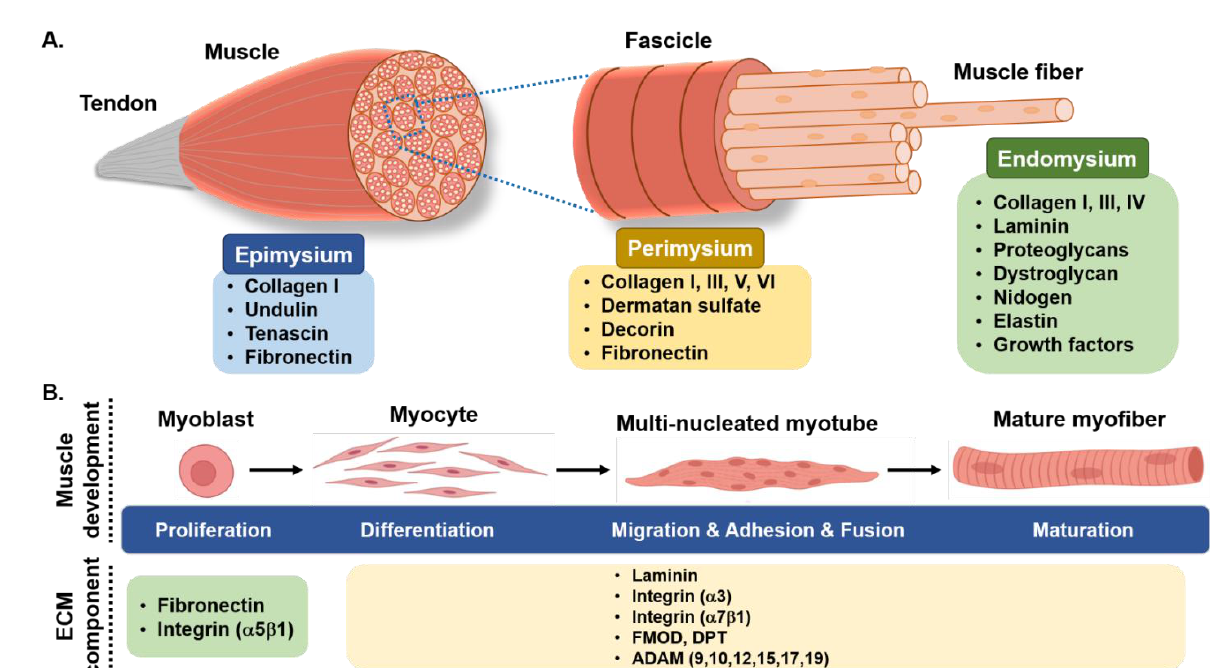
Figure 1. Skeletal muscle ECM: ( A ) three-layer structural schematic and associated ECM components; ( B ) Schematic representation of ECM-related protein activities during the different phases of myogenesis.